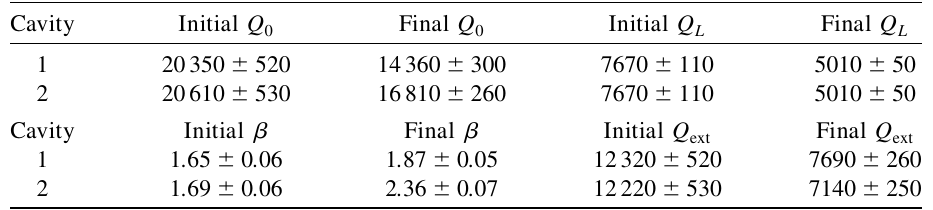
TABLE VI. Cavity Q measurements of cavities 1 and 2 using a HP8510C network analyzer before and after the first high-power test. The change in Q the high-power coupling